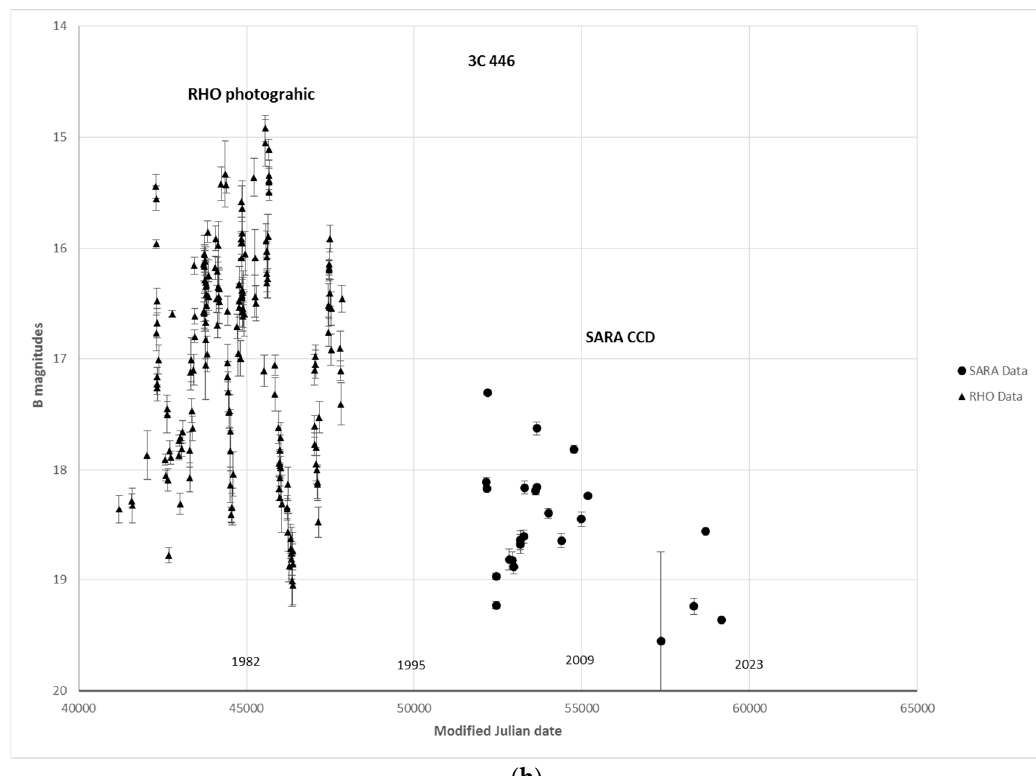
Figure 1. ( a ). The long-term light curve of 3C 120. The B band minus R band offset for this source was determined to be m B -m R = 2.0. N = 775 data points are shown in the plot. ( b ). The long-term light curve of BL Lacertae. The B band minus R band offset for this source was determined to be m B -m R = 1.543 magnitudes; 1623 data points are shown in the plot. ( c ). The long-term light curve of 3C 273. The blue band minus R band offset for this source was determined to be m B -m R = 1.0 magnitudes, N = 91 data points are shown in the plot. ( d ). The long-term light curve of OJ 287. The blue band minus R band offset for this source was determined to be m B -m R = 1.503, N = 376 data points are shown in the plot. ( e ). The Long-term light curve of 3C 279. The B band minus R band offset for this source was determined to be m B -m R = 1.0 magnitudes, N = 282 data points are shown in the plot. ( f ). The long-term light curve of 1156+295. The B band minus R band offset for this source was determined to be m B -m R = 1.0 magnitudes, N = 268 data points are shown in the plot. ( g ). The long-term light curve of AO 0235+164. The blue band minus R band offset for this source was determined to be m B -m R = 2.0 magnitudes, N = 497 data points are shown in the plot. ( h ). The long-term light curve of 3C 446. The blue band minus R band offset for this source was determined to be m B -m R = 1.0 magnitudes. N = 174 data points are shown in the plot.